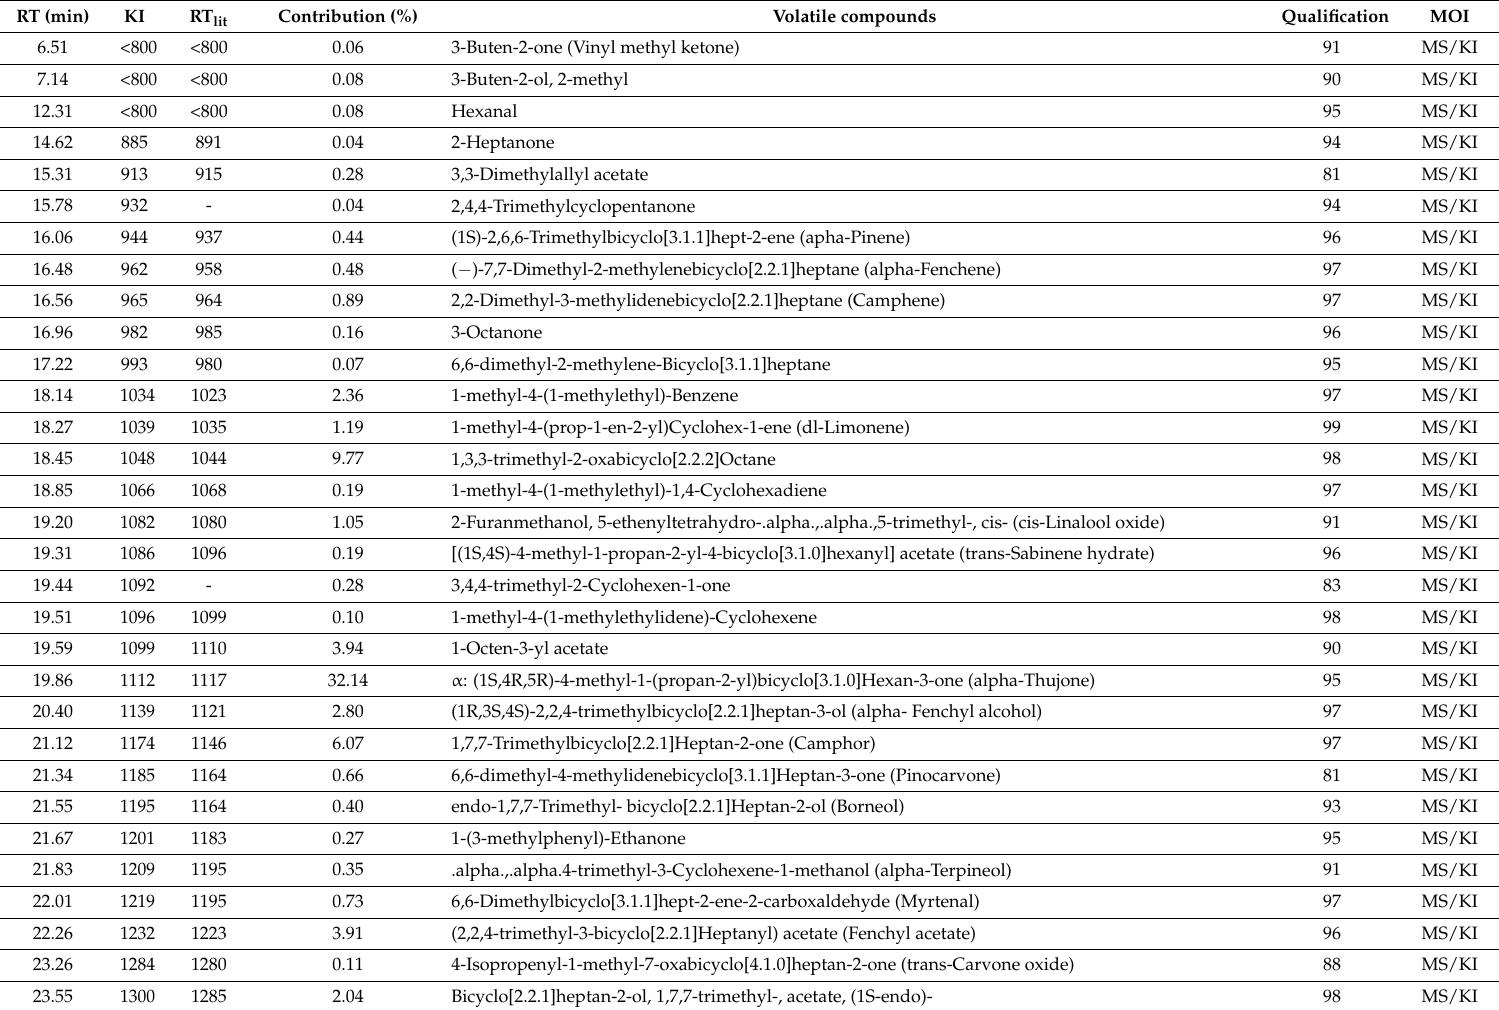
Table 2. Volatile compounds identified in Lavandula